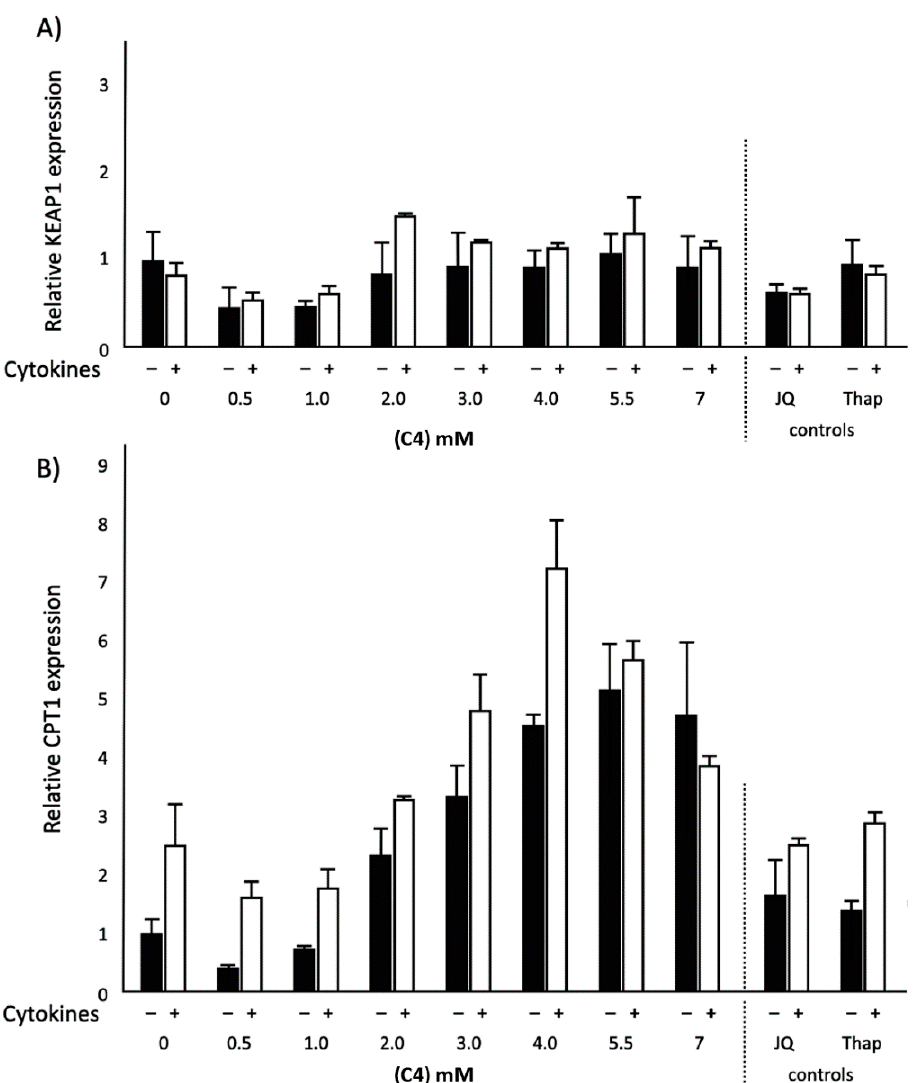
Figure 2. Relative kelch-like ECH-associated protein 1 (KEAP1) and carnitine palmitoyltransferase 1 (CPT1) mRNA expressions in HepG2 cells treated with different concentrations of C4, JQ1(+) (3 μ M) or thapsigargin (Thap) (0.01 µ M). ( A ) Increasing C4 concentrations showed a significant reduction in KEAP1 mRNA expression in the normal condition ( p < 0.05). Increasing C4 concentrations showed a significant increase in KEAP1 mRNA expression in the inflammatory condition ( p < 0.05) ( B ) Increasing C4 concentrations showed a significant increase in CPT1 mRNA expression in both normal and inflammatory conditions ( p < 0.001). All results are presented as the mean, while error bars indicate standard deviations. Data were normalized against the expression observed in the control condition, which was arbitrarily set at 1. A quadratic polynomial regression was performed for C4 dose–response effects. Changes were considered significant when the regression coefficients were significantly different from zero ( p < 0.05).